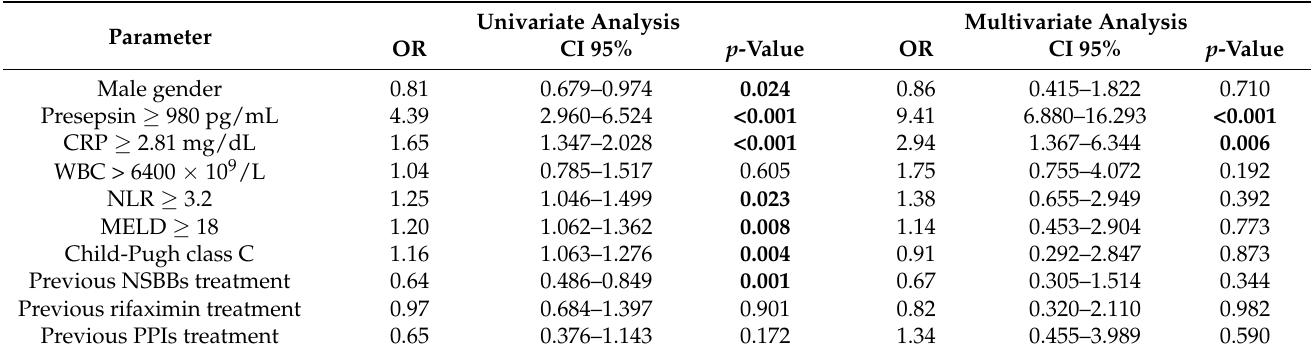
Table 4. Univariate and multivariate logistic regression analyses of factors associated with infections in patients with LC and overt